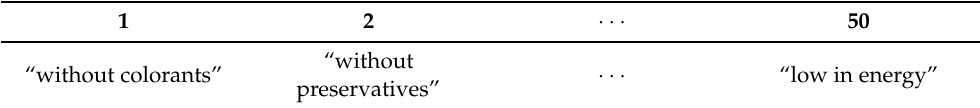
Table 14. Example of the vector which contains all the different features obtained from the Mensajes columns ( withoutwords ).